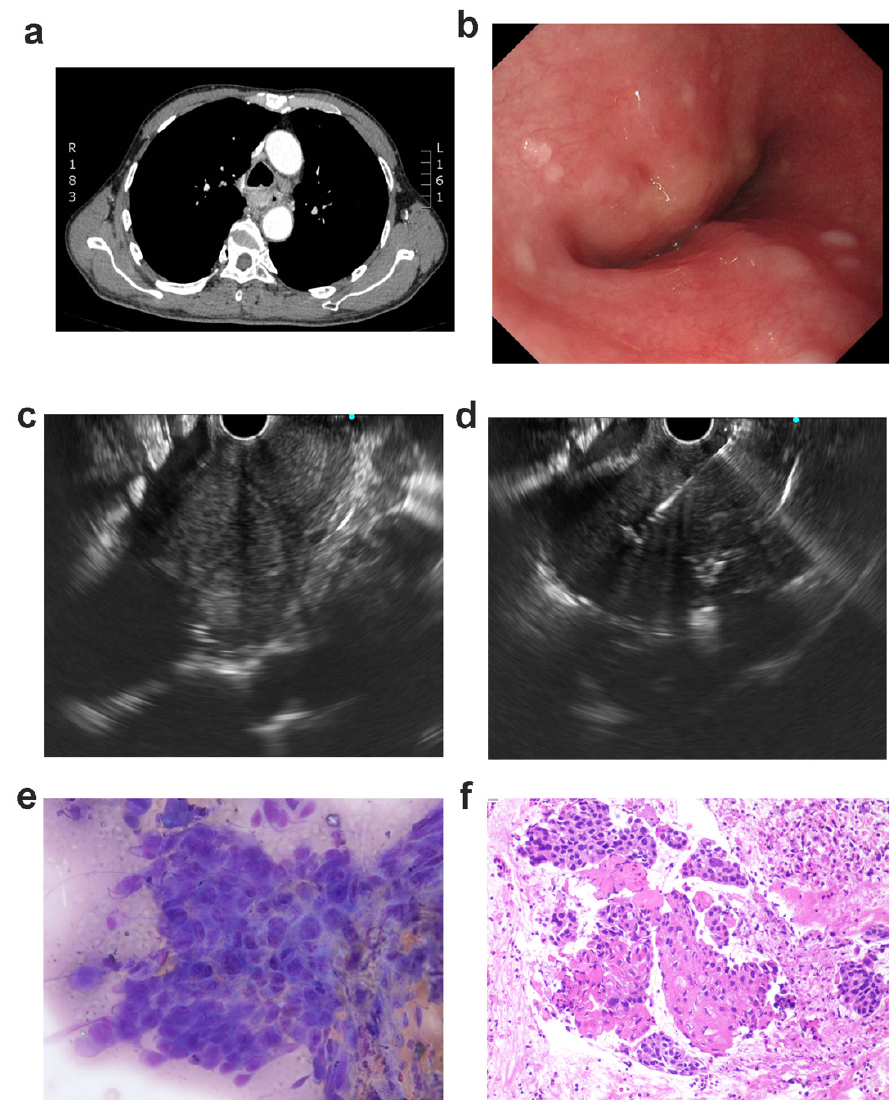
Figure 2. Medical information of patient 14: ( a ) thoracic computed tomography (CT) depicted the thickening of the esophageal wall at the middle esophagus; ( b ) endoscopy depicted esophageal stricture with intact mucosa; ( c ) EUS (endoscopic ultrasound) depicted low-echo lesion at the upper esophagus; ( d ) EUS depicted needle puncture through the esophageal tissue; ( e ) rapid on-site eval- uation depicted malignant cells; ( f ) histological studies with hematoxylin and eosin (H&E) staining showed malignant cells of well-differentiated squamous cell carcinoma captured by EUS-FNA.